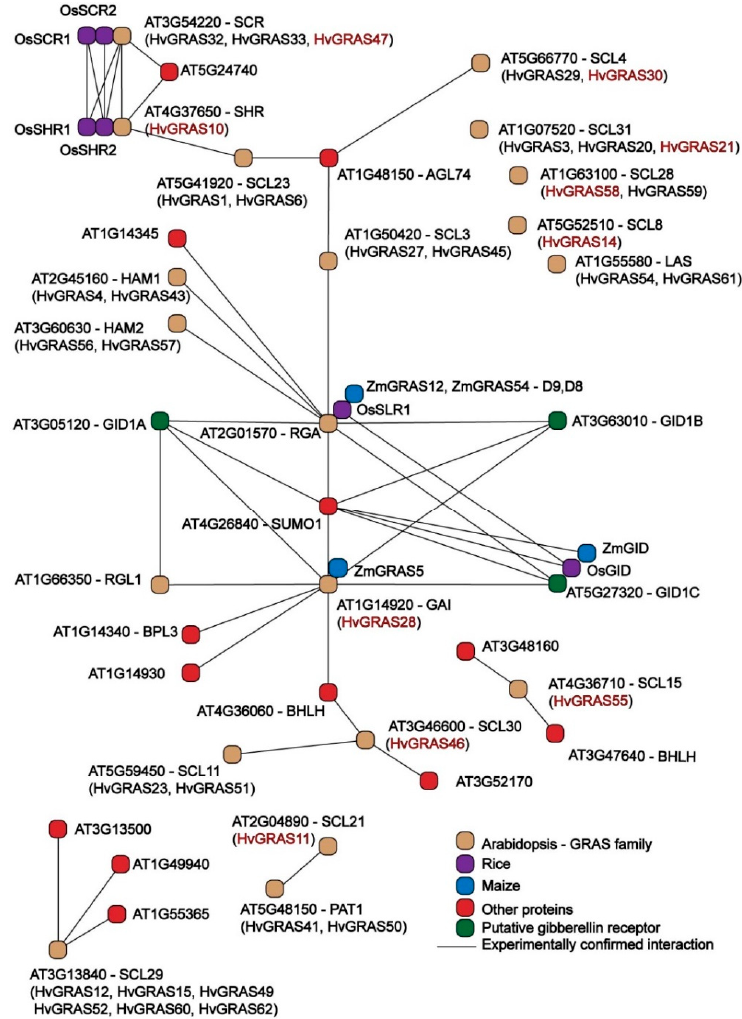
Figure 6. The potential interaction network of HvGRAS based on the Arabidopsis, rice, and maize orthologs. Black lines indicate the interaction, HvGRAS found expressed in developing spike are marked in red.